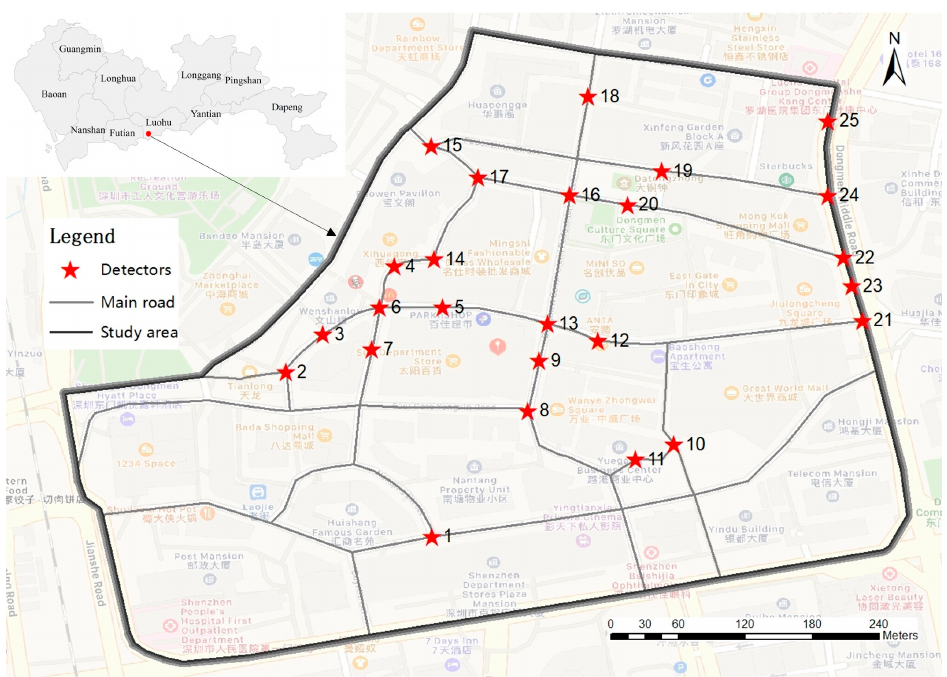
Figure 1. The geographical distribution of the equipped detectors in Dongmen walking street, Shenzhen, China. (The basemap is collected from Apple maps).